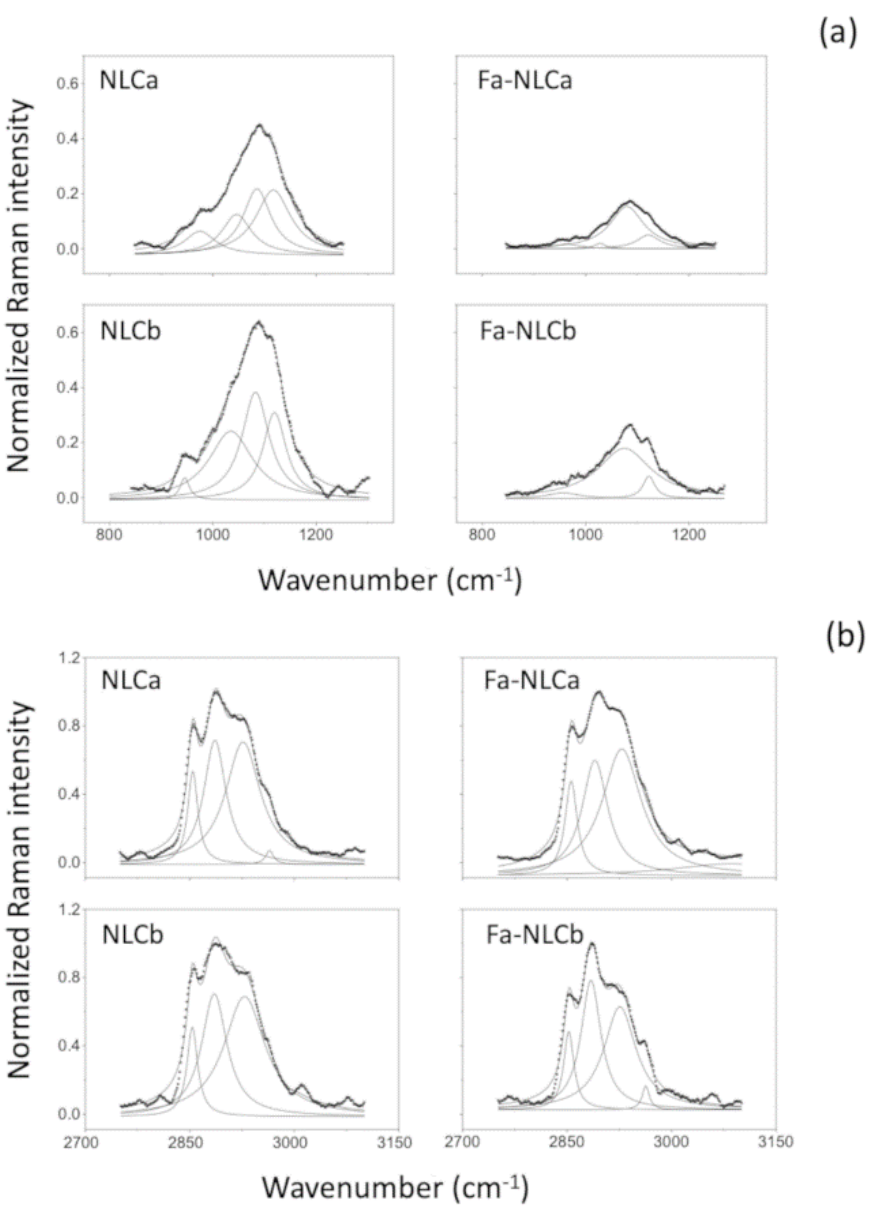
Figure 3. Raman spectra of unloaded and FA-loaded NLCa and NLCb. Table 3. Raman intensity ratios related to C-C stretching vibrational bands, I 1115 / I 1050 , and Intensity Raman ratios, I 2890 / I 2850 , for the C–H stretching vibrational bands of unloaded and FA-loaded NLC. Values are the mean of the intensity of 100 accumulation spectra acquired from five di ff erent regions with a spatial resolution of 5 microns in each sample. SD is < 0.02 for all averages. * Significance for p <